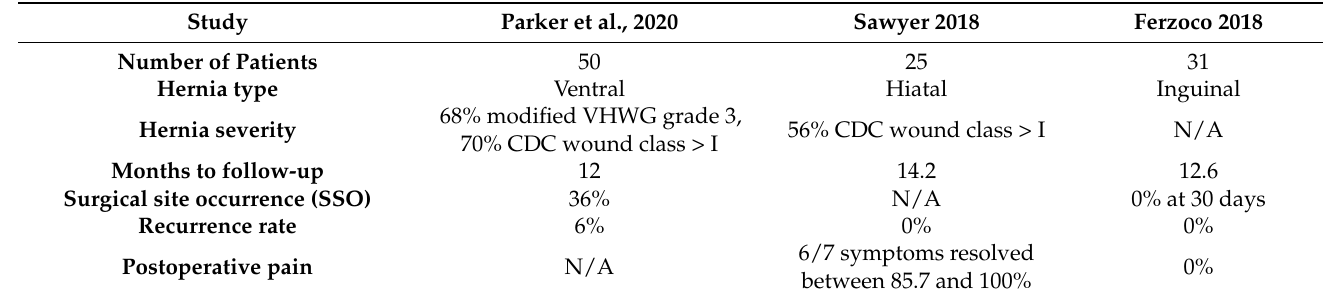
Table 1. Follow-up data and results of various surgical hernia repair studies where RTMs were used for repair.